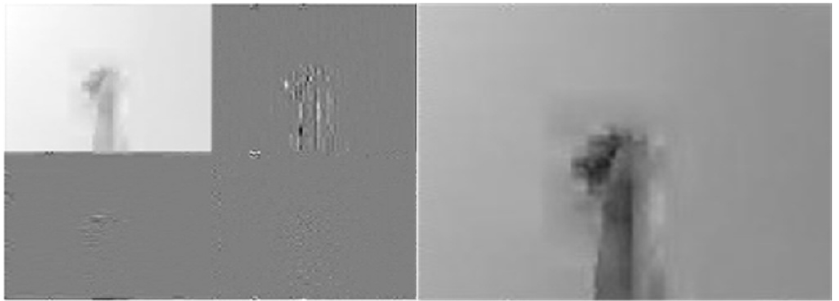
Figure 10. The “max-min” merge strategy performed on two 1st-level DWT coefficients derived from CCD RGB-IR and depth-grayscale hand gesture images ( the left ) and the IDWT-decoded recovery image of the “max-min” merged ( the right ) for VGG-16 CNN deep learning.